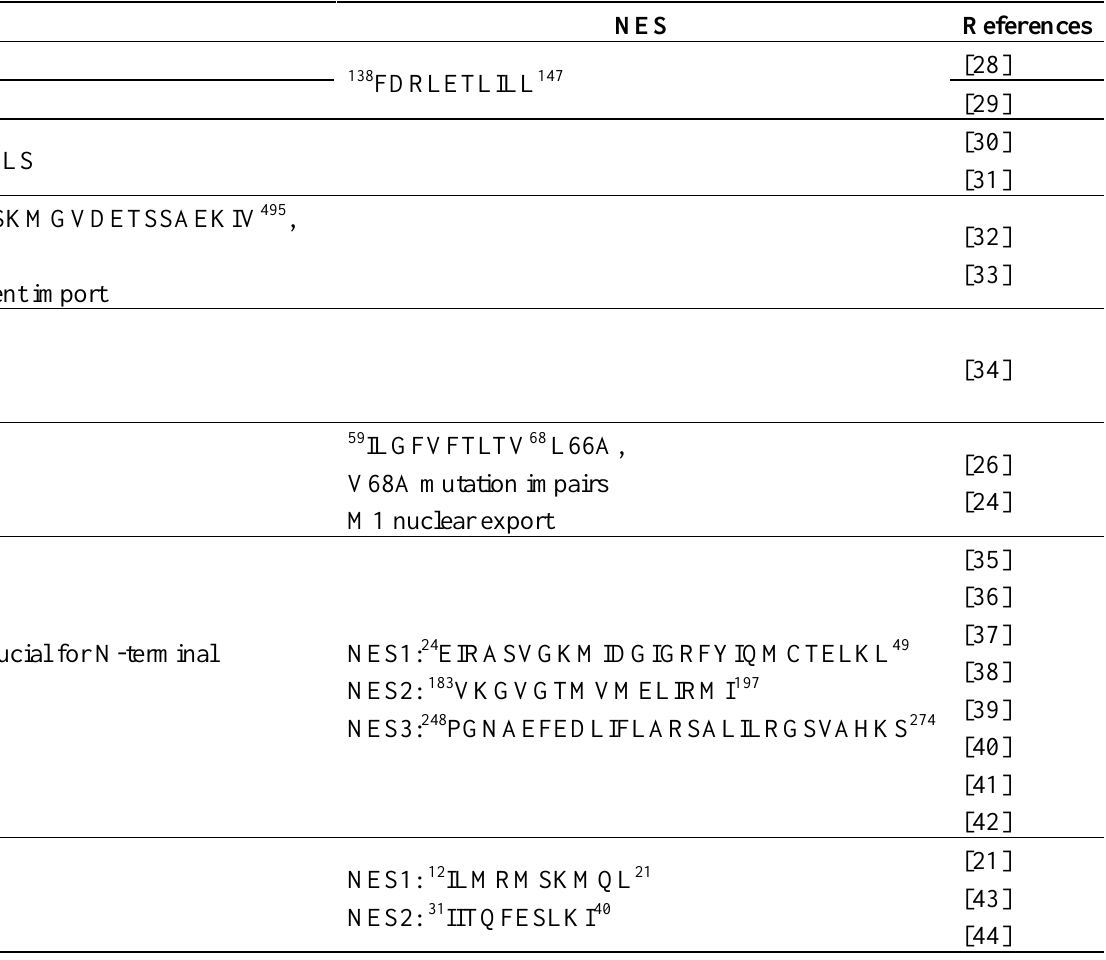
Table 1. List of influenza A virus protein nuclear localization signals (NLSs) and nuclear export signals (NESs). Protein NLS